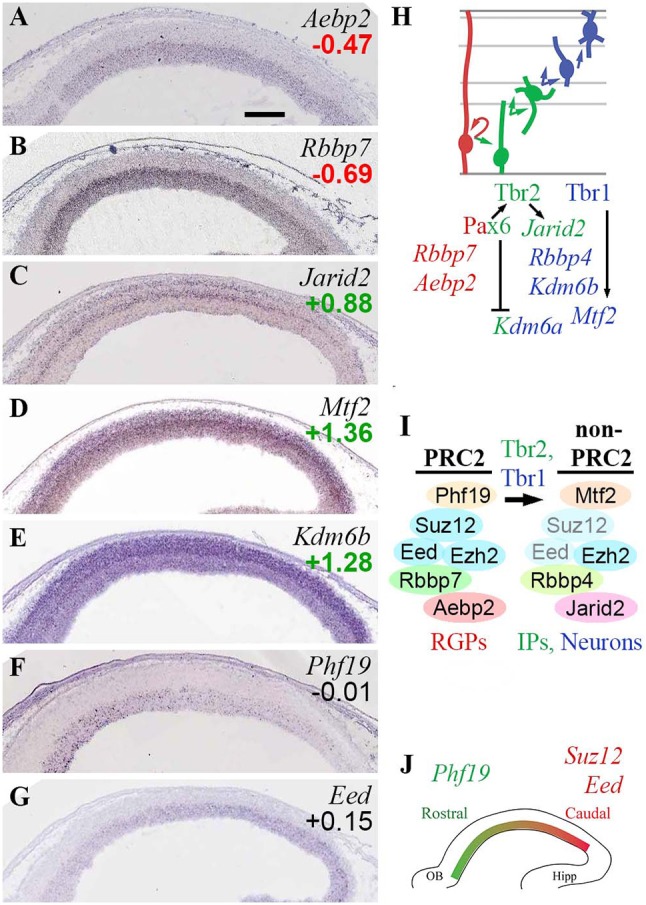
PRC2 complexes. (A–G) Expression of indicated genes. ISH: Genepaint. Scale bar: 100 μm. (H) Summary of subunit gene expression and regulation. (I) Changes in PRC2 subunit expression were associated with PN differentiation, and were regulated by Tbr1/2. Eed and Suz12 subunits were downregulated in differentiating cells (transparent subunits), potentially leading to formation of “non-PRC2” Ezh2 complexes. (J) Graded expression of PRC2 subunits is important in cortex regionalization, but these genes are not under direct control of Pax6, Tbr2, or Tbr1.